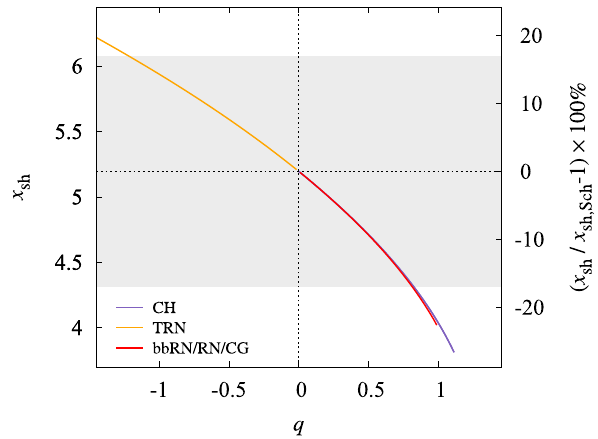
Fig. 7 Thedimensionlessradius x sh (left y -axis)fortheblack-bounce- Reissner–Nordström spacetime (bbRN), the Reissner–Nordström black hole (RN), the tidal Reissner–Nordström black hole (TRN), the charged Horndeski black hole (CH) and the charged Galileon black hole (CG), and its relative deviation (right y -axis) from the one of the √ Schwarzschild black hole x sh , Sch = 3 3. The grey area shows the allowed range of x sh by the EHT measurement of M87*’s